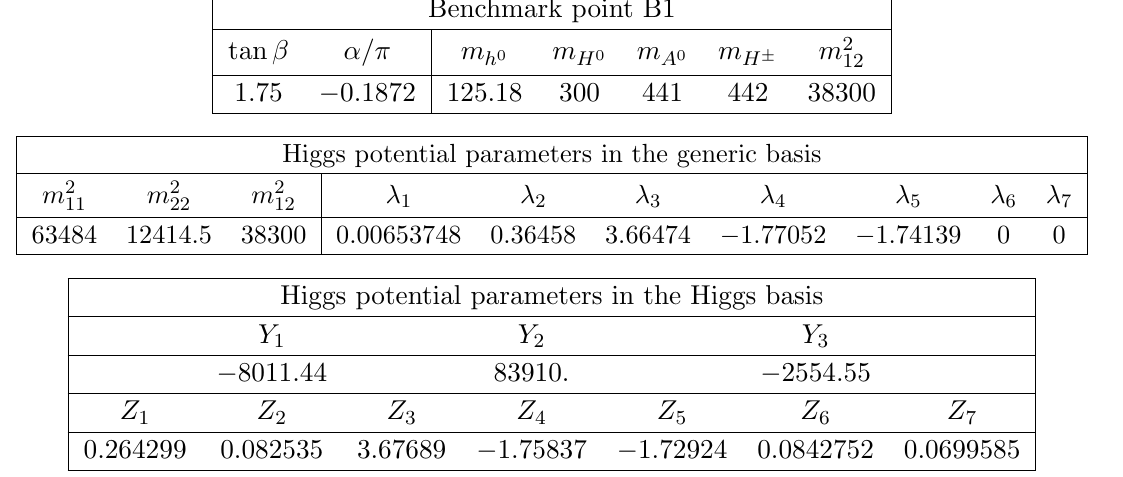
p = 2, needed to calculate the F or jk